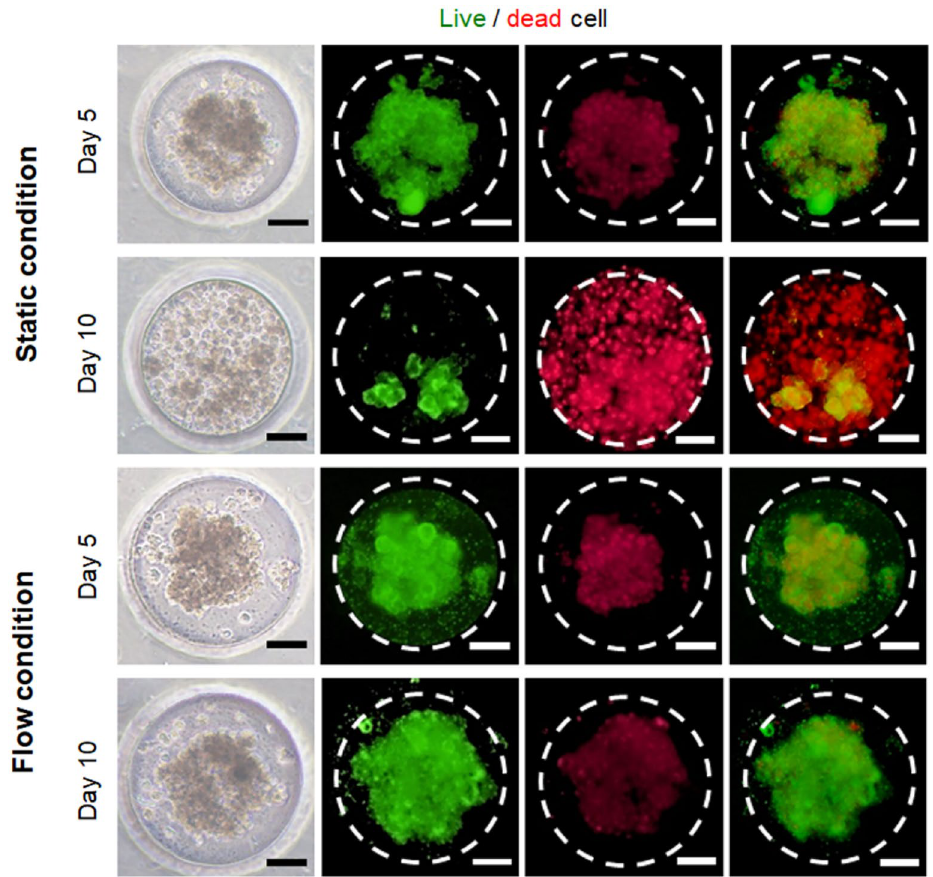
Fig. 4 HepG2 spheroid formation within microwell arrays after 5 and 10 days in a gut‑liver axis chip. Light microscopic images of hepG2 spheroids formed in microwell arrays. Spheroid image after cultured in flow and static condition (live and dead cells were stained with green and red, respectively). Scale bars are 50